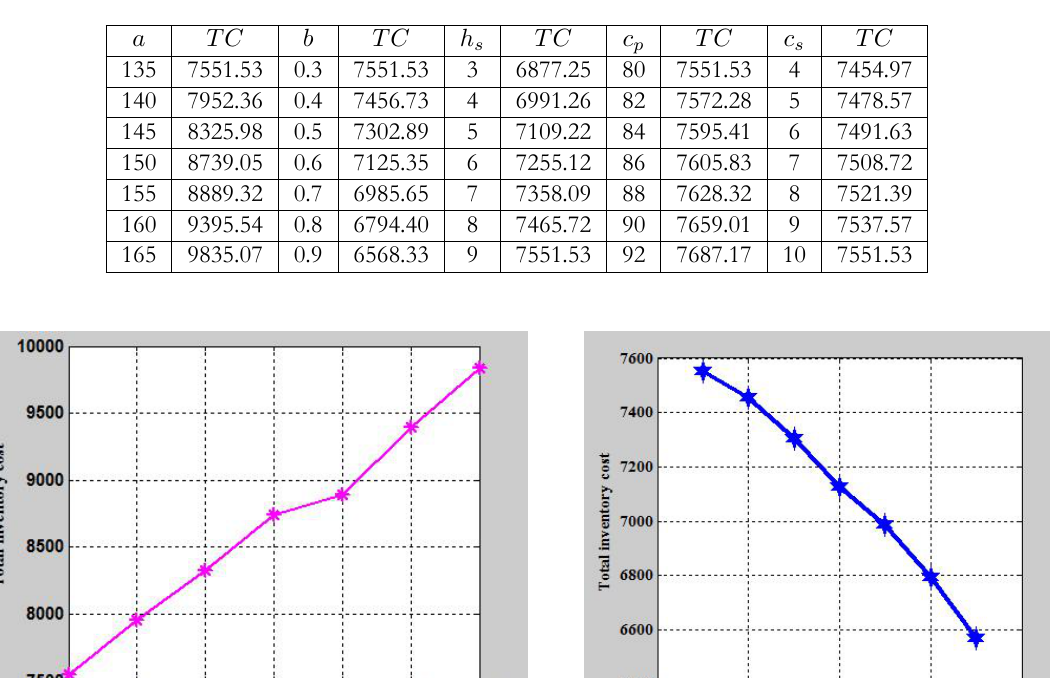
Table 1: Sensitivity with various parameters v/s total inventory cost